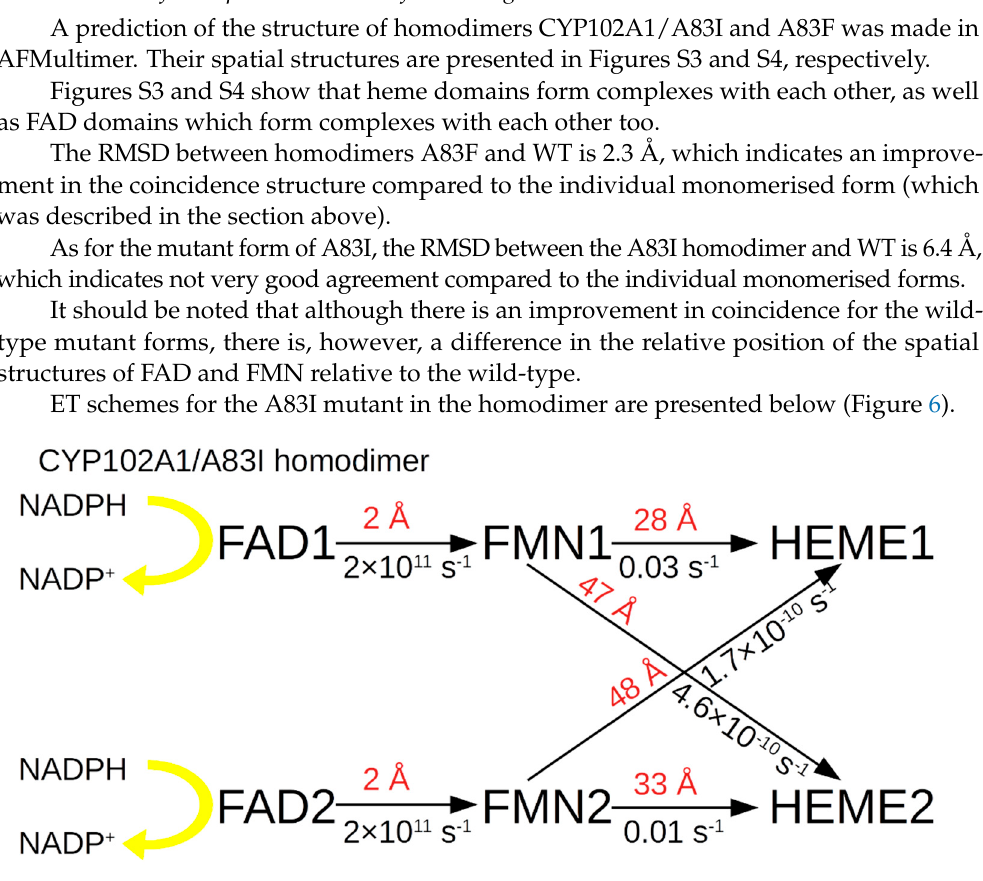
Figure 6. Schematic diagram of electron transport in the electron transport chain of the homodimer in CYP102A1/A83I. in